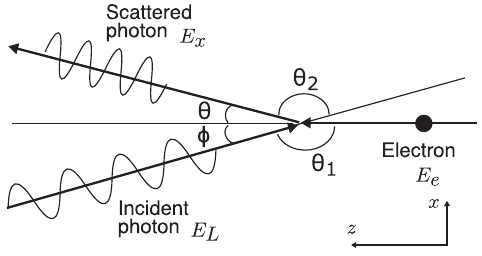
FIG. 1. Schematic of laser Compton